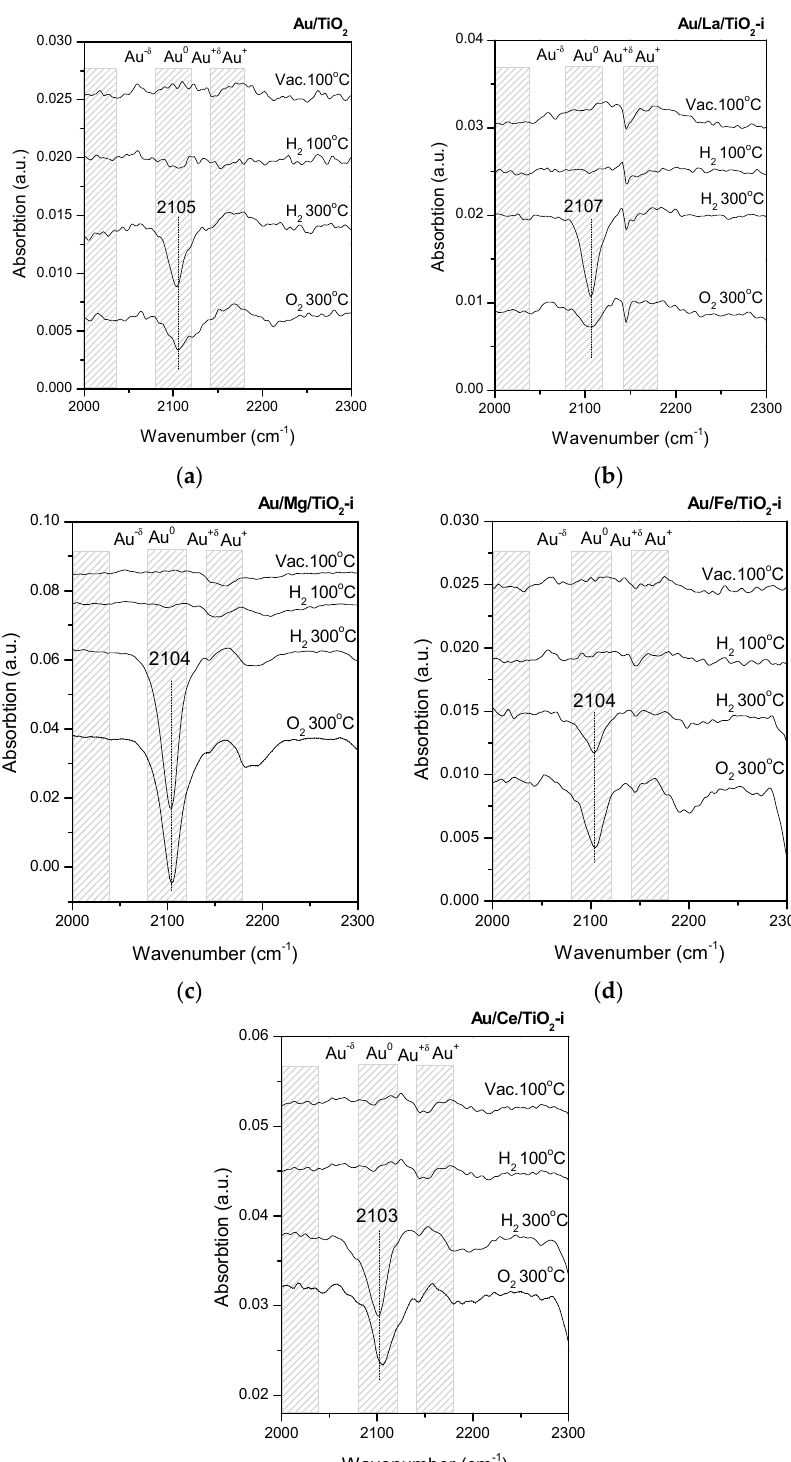
Figure 4. FTIR spectra of CO adsorbed on for Au/TiO 2 ( a ); Au/La/TiO 2 -i ( b ); Au/Mg/TiO 2 -i ( c ); Au/Fe/TiO 2 -i ( d ); Au/Ce/TiO 2 -i ( e ).